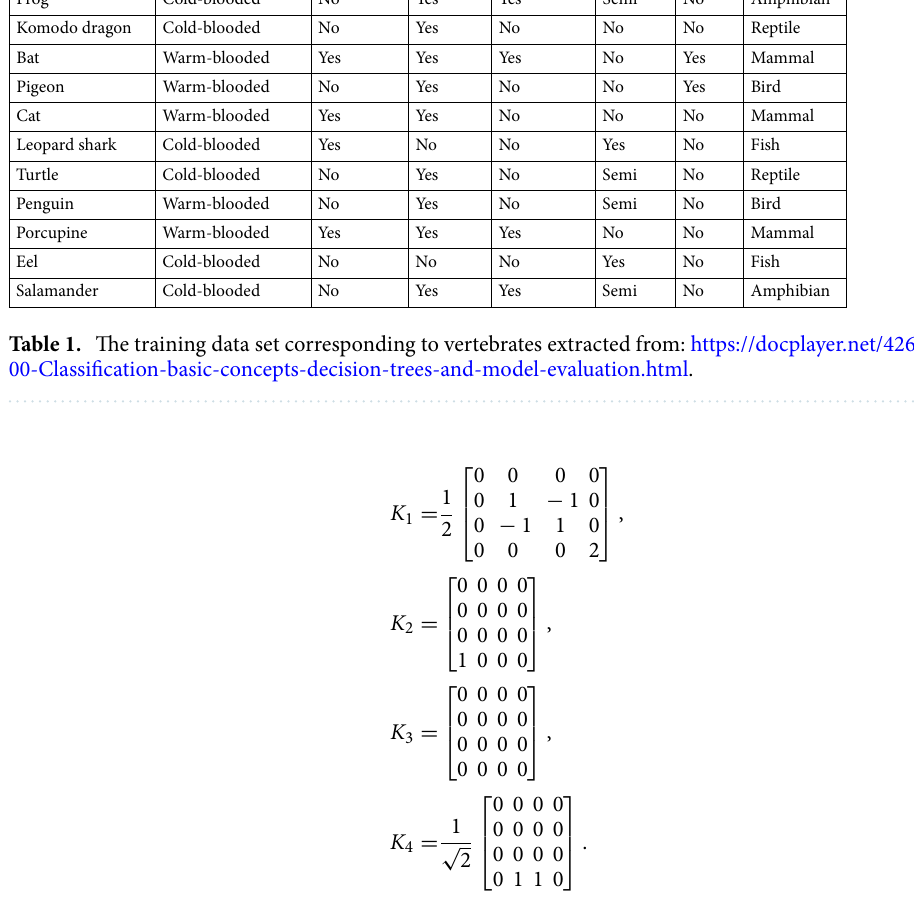
Record Body temperature Give birth Has legs Hibernates Aquatic Aerial Class label Human Mammal Python Salmon Fish Whale Warm-blooded Yes Mammal Frog Komodo dragon Pigeon